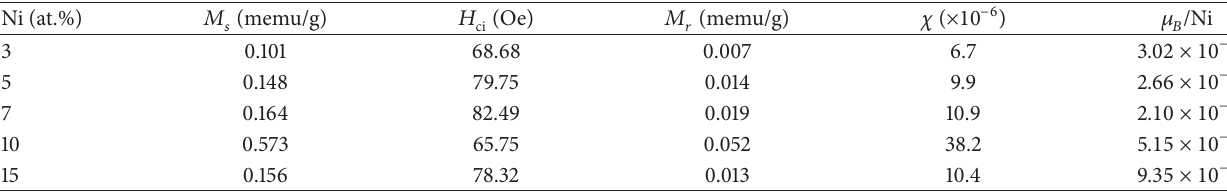
), retentivity ( 𝑀 𝑟 ), magnetic susceptibility ci powder samples. 2